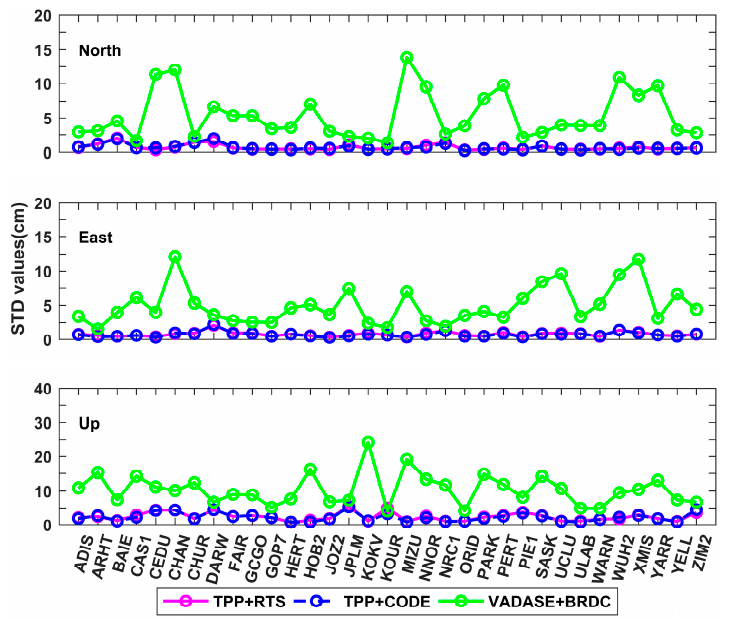
Figure 7. The standard deviation (STD) values of the derived displacements in north, east and up directions for different schemes at each station.